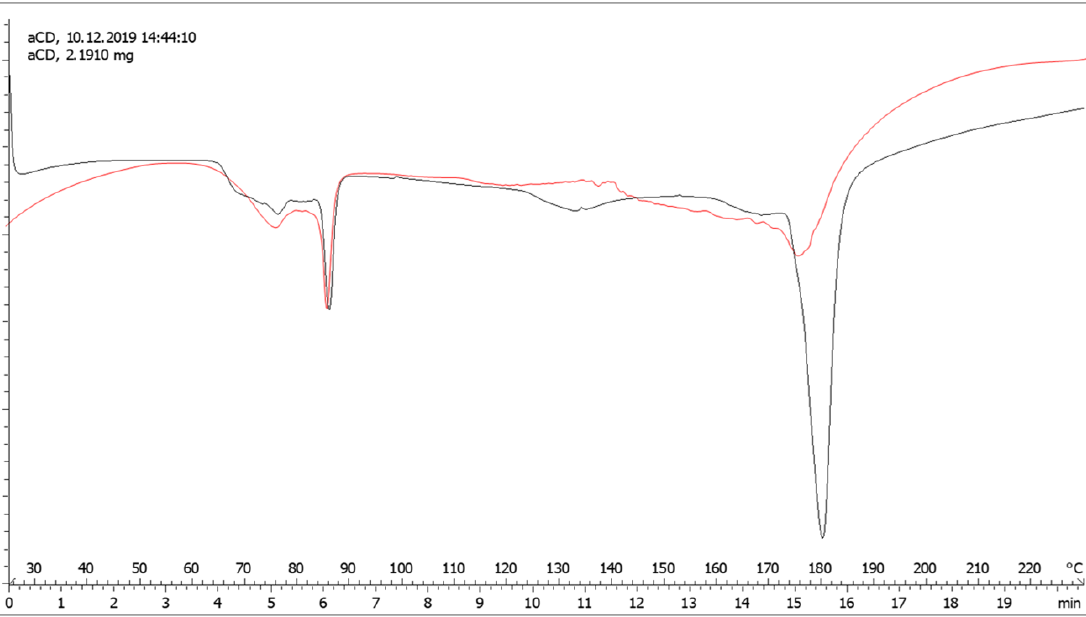
Figure 4. DSC thermograms of α -CD (black line) and EVOO- α CD inclusion complex (red line).